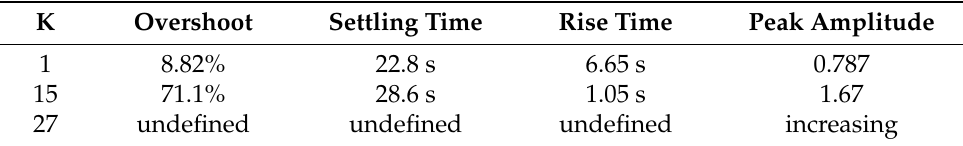
Table 4. Pitch control system responses at different gains.